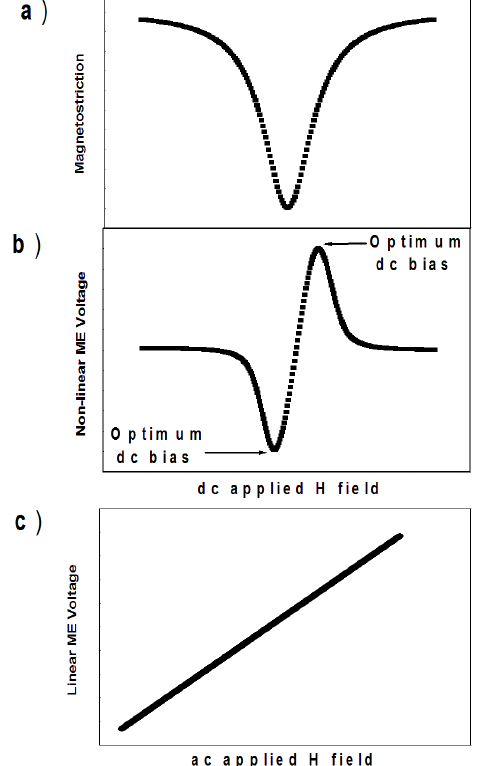
Figure 2. ( a ) Typical magnetostriction coefficient dependence on the DC-applied magnetic field; ( b ) typical dependence of magneto-electric induced voltage as a function of DC magnetic bias field, at constant AC magnetic field amplitude and frequency; Figure ( a , b ) have the same horizontal axis. ( c ) Typical dependence of magneto-electric induced voltage as a function of AC magnetic field, at constant DC magnetic bias field.